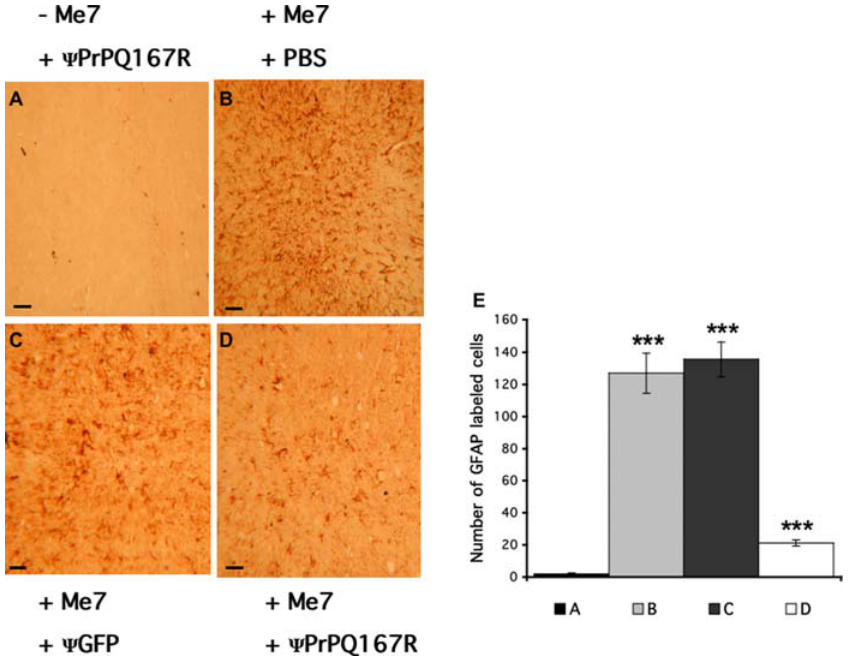
Figure 7. Immunohistochemistry for GFAP in thalamus sections close to the injection site. The plus ( + ) and minus ( 2 ) signs indicate that the mice were or were not inoculated (A), respectively, with the ME7 prion strain. Mice received two injections of either PBS (B) or lentivirus carrying the GFP (C) or PrPQ167R genes (D). GFAP labelling was performed on nine independent brains (3 per group). The sections presented here are representative of the global labelling in the thalamus. Bars, 6 m m. Histograms represent the mean number of GFAP-labelled cells in one mouse of each treated group, which was measured by counting the GFAP-positive cells in five squares of 10,000 m m 2 each, using Mercator software. The histograms represent the means 6 s.e.m. Statistical analysis was performed using STATVIEW 5 software. Values were analyzed by ANOVA followed by the PLSD Fisher test (n=5). Multiple comparison analysis between A, B, C, and D showed that they were all statistically significant (***, p , 0.0001), except for A versus D and B versus